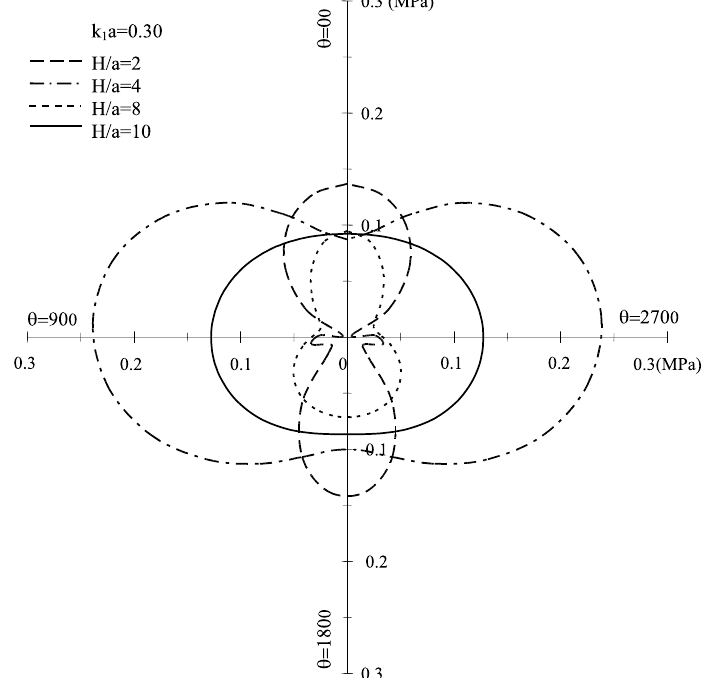
Fig. 8. Variation of the circumferential normal stress ( τ θθ ) with θ at r = a for various values of depth H/a .